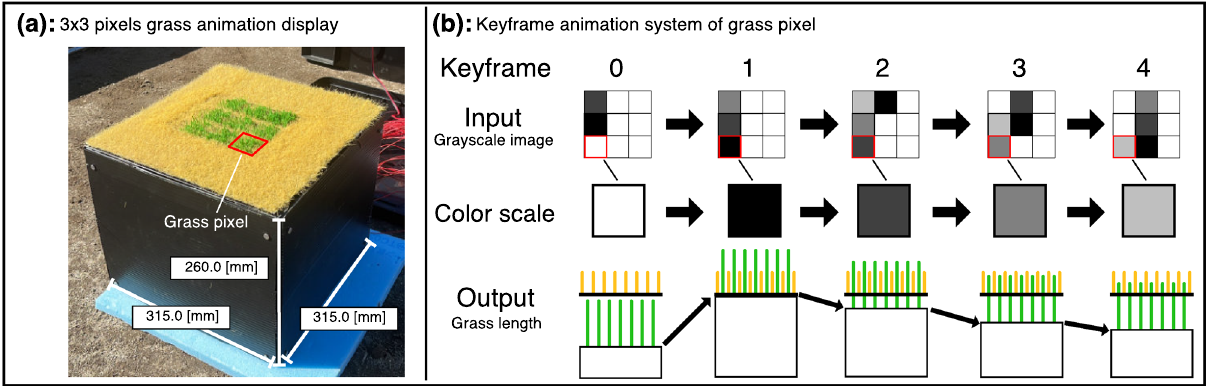
Figure 9. Animation system of a grass animation display used for demonstration. ( a ) A 3 × 3 pixels grass animation display was developed using nine grass pixels. ( b ) A keyframe animation system was adopted to play an animation on the grass animation display. A green length of a grass pixel was changed according to input levels of a color scale in keyframe order. This figure was created using Serif Affinity Designer version 1.10.0 (https:// affin ity. serif. com/ en-